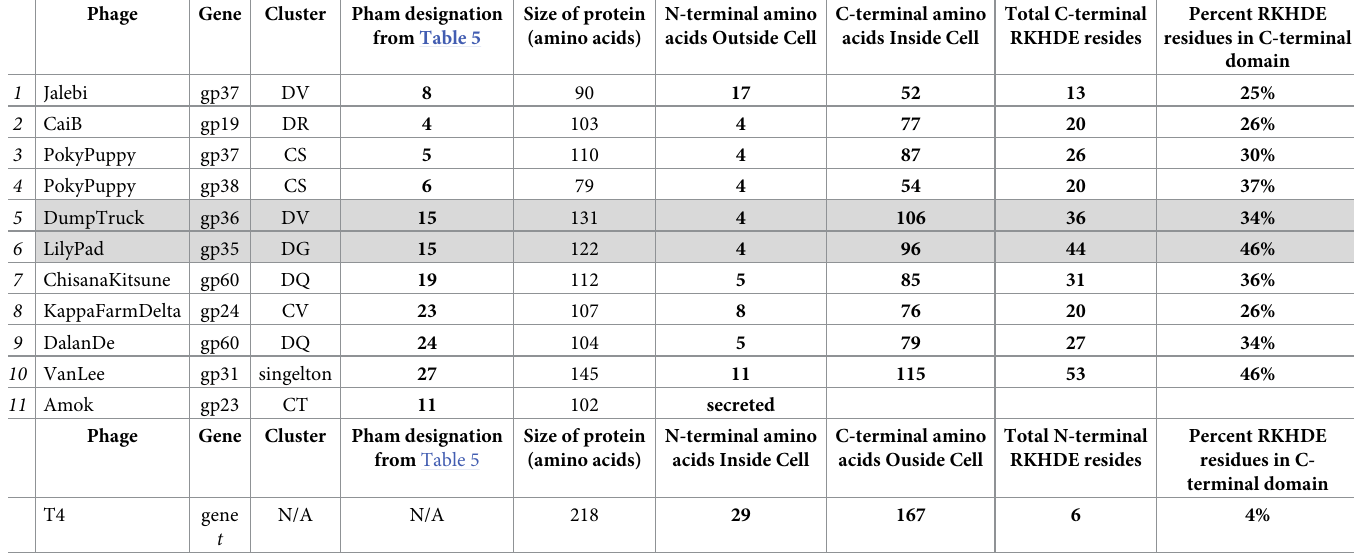
Proteins that are grouped to the same Phams are shaded. Information on protein T from phage T4 is provided in the last row for comparison. N/A = not